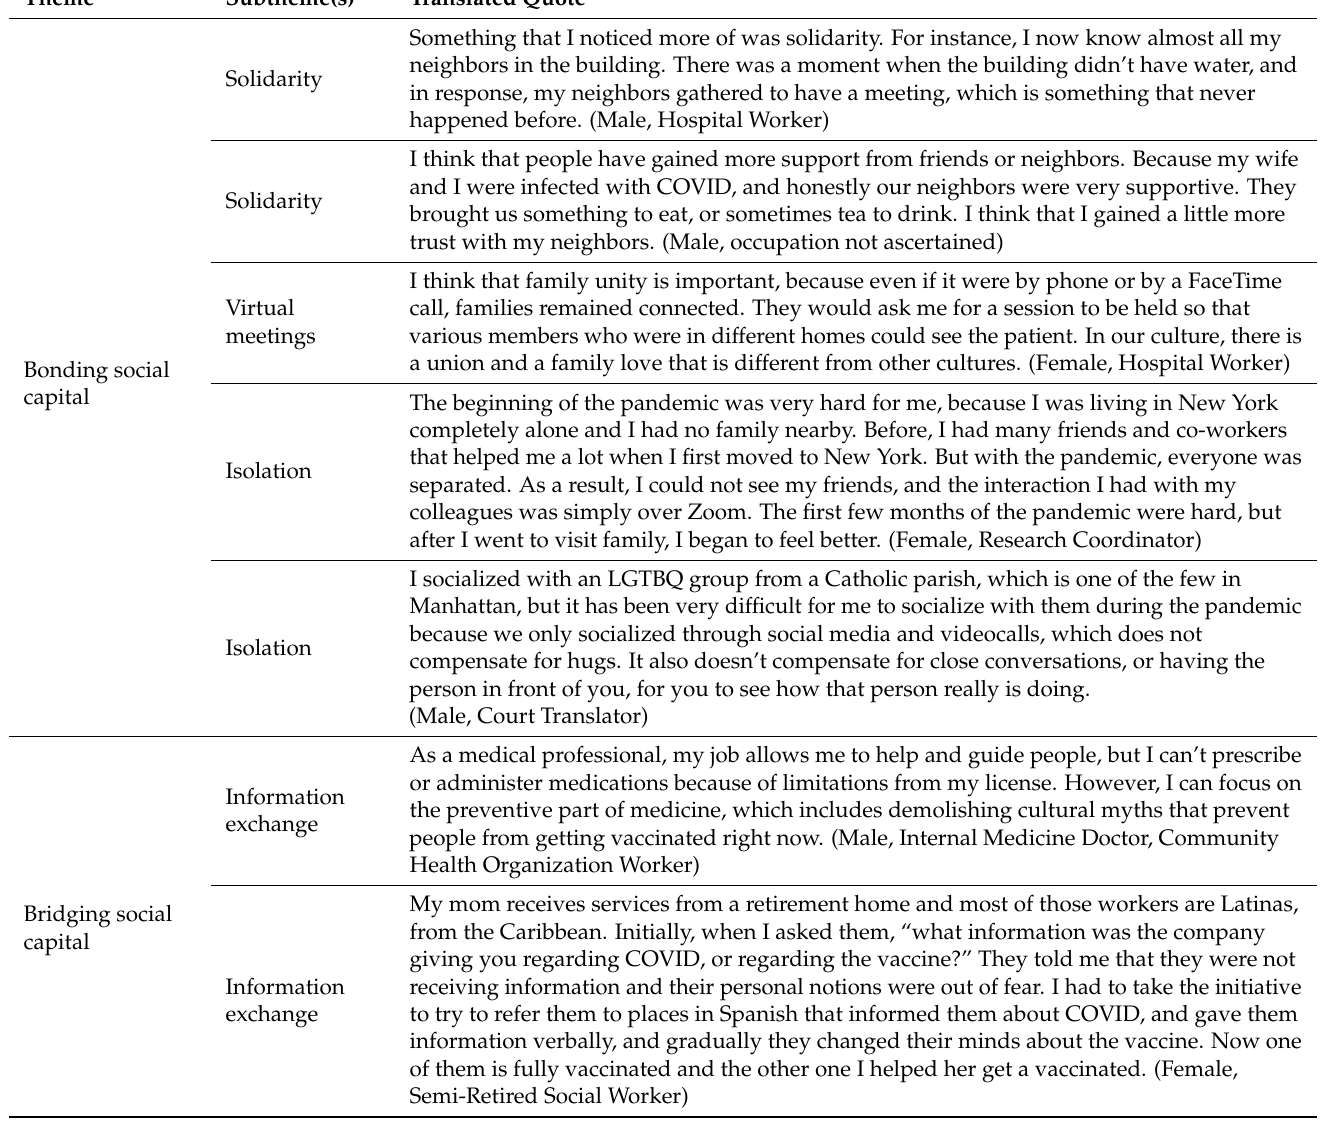
Table 2. Topics under investigation with themes and quotes derived from focus group discussions (n =